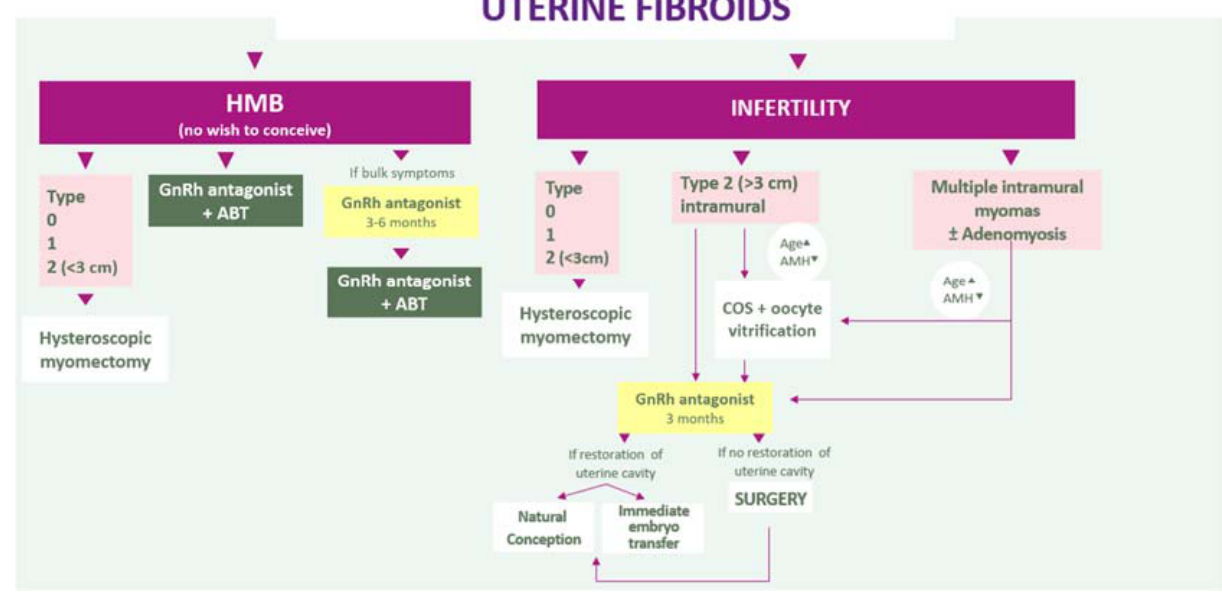
Figure 8. Algorithms that consider both myoma type and the most troublesome symptoms (HMB associated or not with pain or infertility).